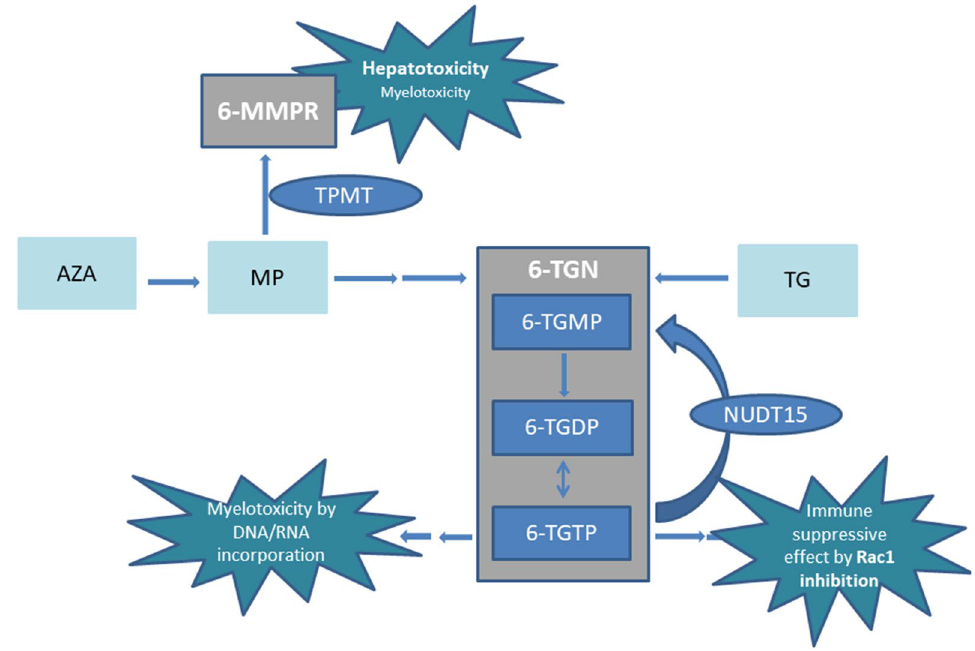
Figure 1. A simplified scheme of thiopurine metabolism. 6-MMPR 6-methylmercaptopurine ribonucleotides, 6-TGMP 6-thioguanine monophosphate, 6TGDP: 6-thioguanine diphosphate, 6TGTP 6-thioguanine triphosphate, 6-TGN 6-thioguanine nucleotides, AZA azathioprine, MP mercaptopurine, NUDT15 Nudix hydrolase 15, Rac1 Ras-related C3 botulinum toxin substrate-1, TG tioguanine, TPMT Thiopurine S-Methyl